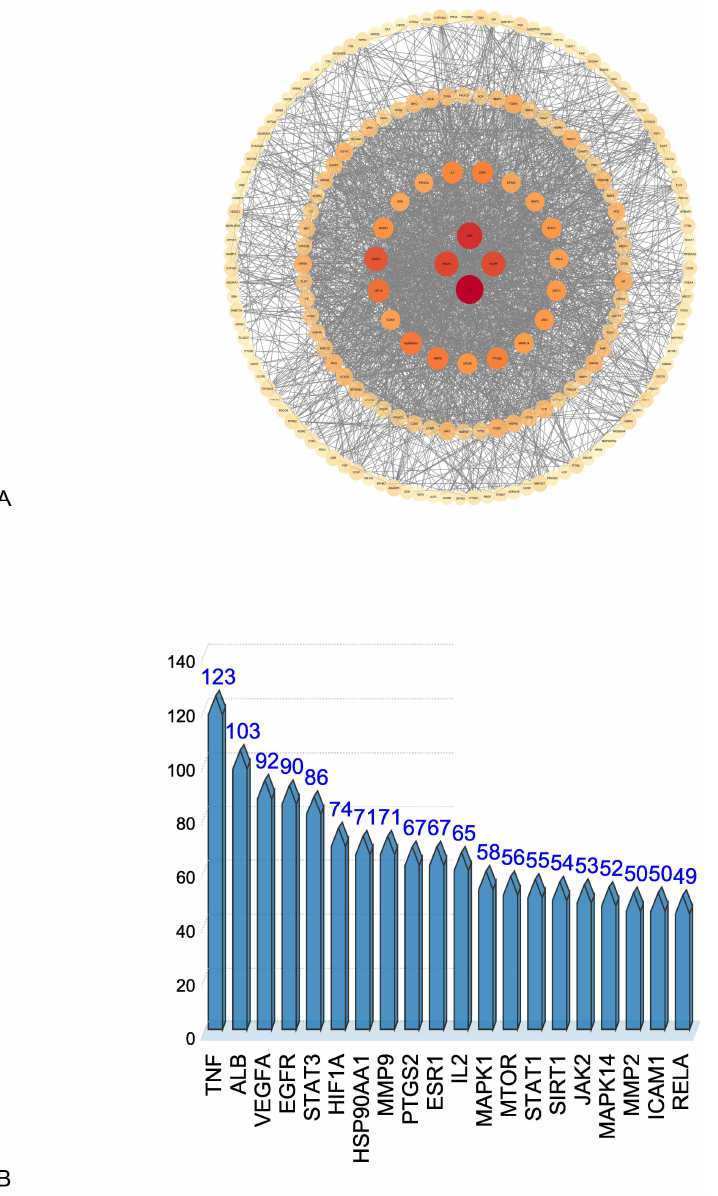
Figure 4. PPI network and 3D bar graphs. ( A ) PPI network (the size and color depth of the nodes are correlated with their degree), ( B ) 3D bar graphs of the top 20 targets.